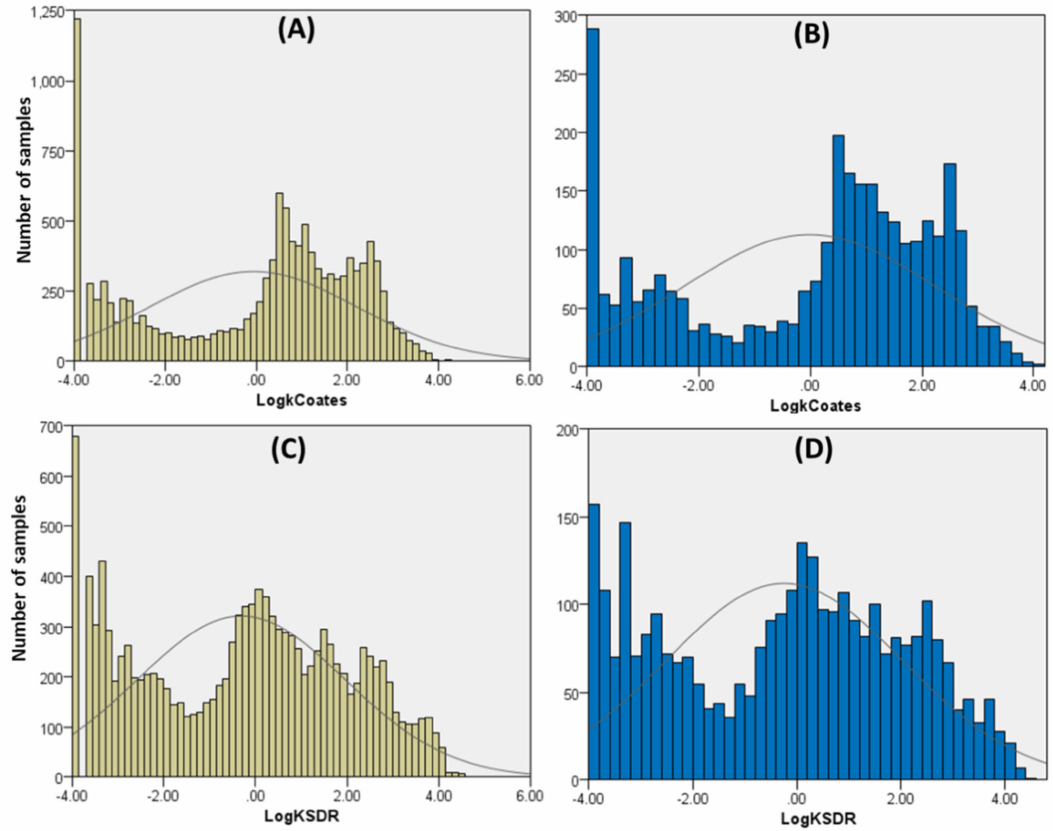
Figure 5. Distribution of the logarithm of Coates and SDR permeabilities in training ( A , C ) and blind ( B , D )